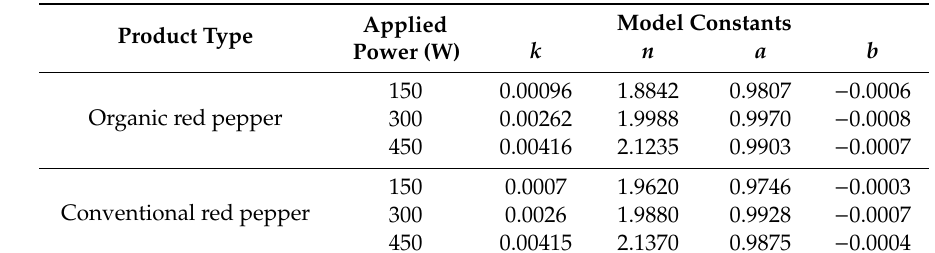
Table 5. Model constants of the Midilli model for the intermittent microwave drying of organic and conventional sweet red pepper slices.